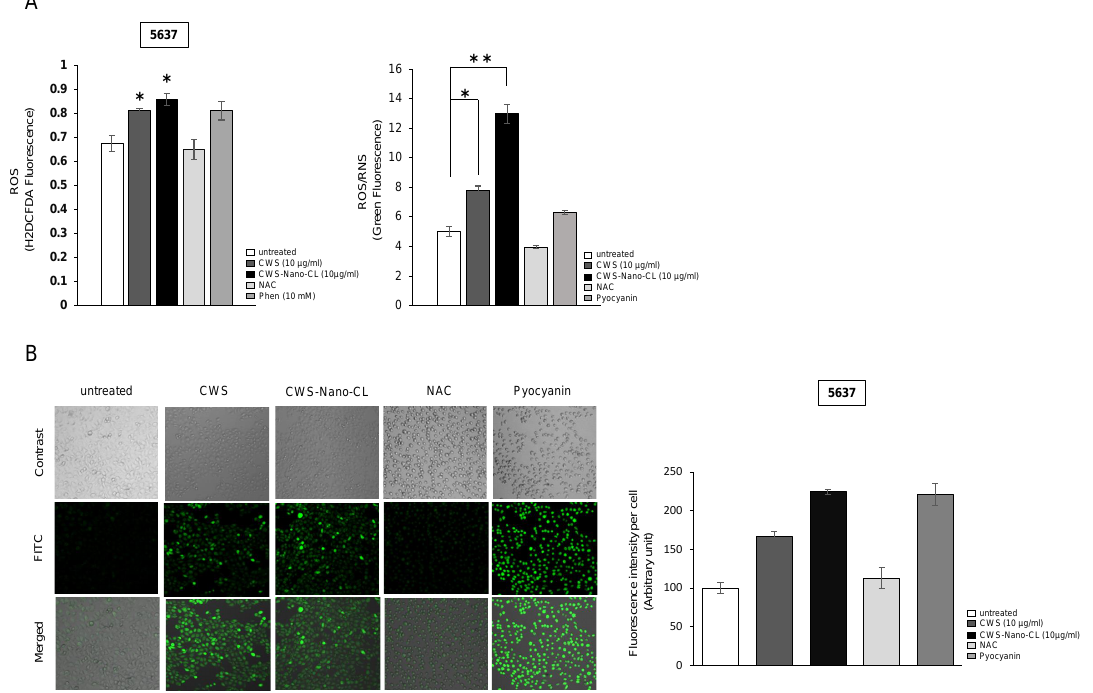
Figure 4. E ff ect of CWS-loaded formulations on reactive oxygen species (ROS) production in bladder cancer cells. ( A ) Cells were treated with 10 µ g / mL of CWS or CWS-Nano-CL for 24 h and then treated with NAC (2 mM, positive control) for 30 min. After washing, cells were treated with H 2 DCFDA (10 µ M) for 1 h prior to measurement. ROS / RNS production was measured using a ROS-ID ® ROS / RNS detection kit. Pyocyanin (500 µ M) and NAC (5 mM) were added as a positive and a negative control for 30 min. * p < 0.005, ** p < 0.0005; untreated / CWS or untreated / CWS-Nano-CL. Data are mean ± SEM ( n = 6). ( B ) Fluorescence images of ROS / RNS production in live cells were taken using a confocal microscope (Leica DMI8) and quantified with the ImageJ software program (lower panel). Data are mean ± SEM ( n =